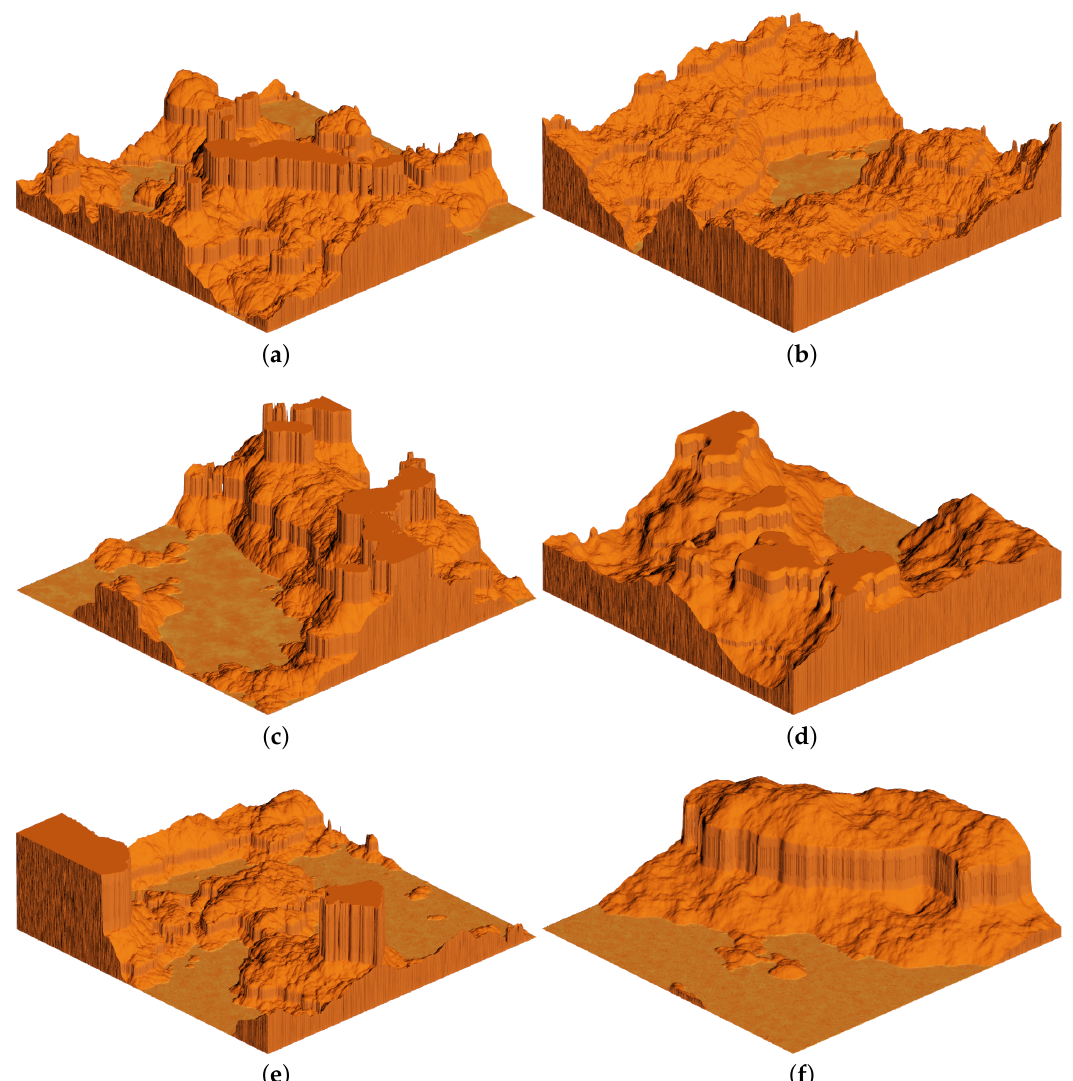
Figure 20. Examples of mesa-like assets obtained by the proposed techniques (grid resolution: 1024 × 1024). ( a ) Fault radius: 1 (cid:54) r (cid:54) 350; total faults: 999; mat = 5. Erosive model was obtained for E = 0.65 with caprock and (cid:36) = 1. ( b ) Fault radius: r = 300 each; total faults: 500; mat = 5. Erosive model was obtained for E = 0.35 with caprock and (cid:36) = 1. ( c ) Fault radius: r = 512 each; total faults: 1500; mat = 5. Erosive model was obtained for E = 0.75 with caprock and (cid:36) = 1. ( d ) Fault radius: r = 250 each; total faults: 2500; mat = 4. Erosive model was obtained for E = 0.25 with caprock and (cid:36) = 10. ( e ) Fault radius: r = 250 each; total faults: 750; mat = 4. Erosive model was obtained for E = 0.4 with caprock and (cid:36) = 2. ( f ) fault radius: r = 500 each; total faults: 3500; mat = 3. Erosive model was obtained for E = 0.75 with caprock and (cid:36) =